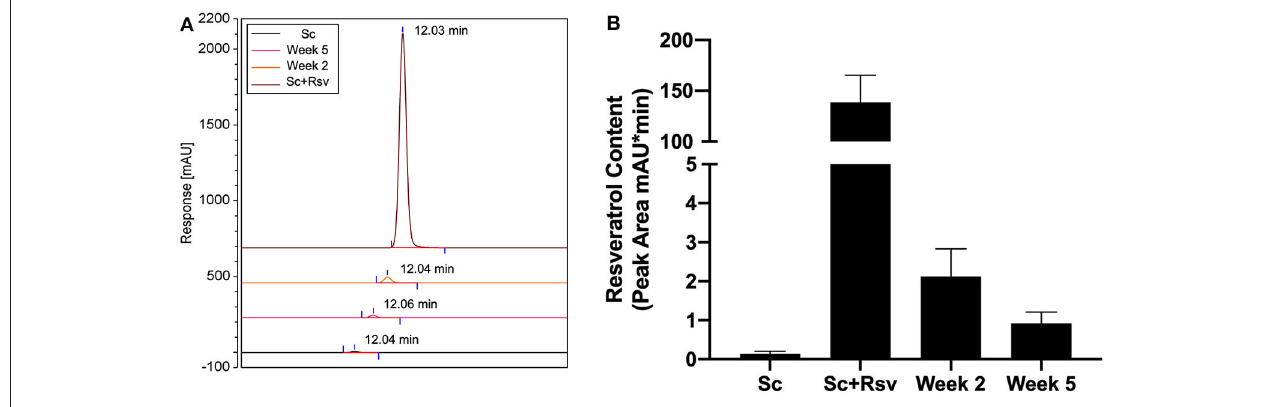
FIGURE 8 | Resveratrol content in epididymal fat 2 and 5 weeks after scaffold implant. (A) HPLC chromatograms depicting resveratrol content in epididymal fat 2 and 5 weeks after implanting resveratrol scaffolds. For comparison, epididymal fat pads that did not receive scaffolds but were homogenized with either fresh resveratrol scaffolds (Sc + Rsv) or blank scaffolds (Sc) were included for comparison. The elution for each condition was offset by 10% when combined into a single graph. Elution times for resveratrol are labeled on the graph and were the same for all samples ( ∼ 12min). (B) Resveratrol content in the epididymal fat depicted as peak area calculated from HPLC chromatograms. n = 3 mice per